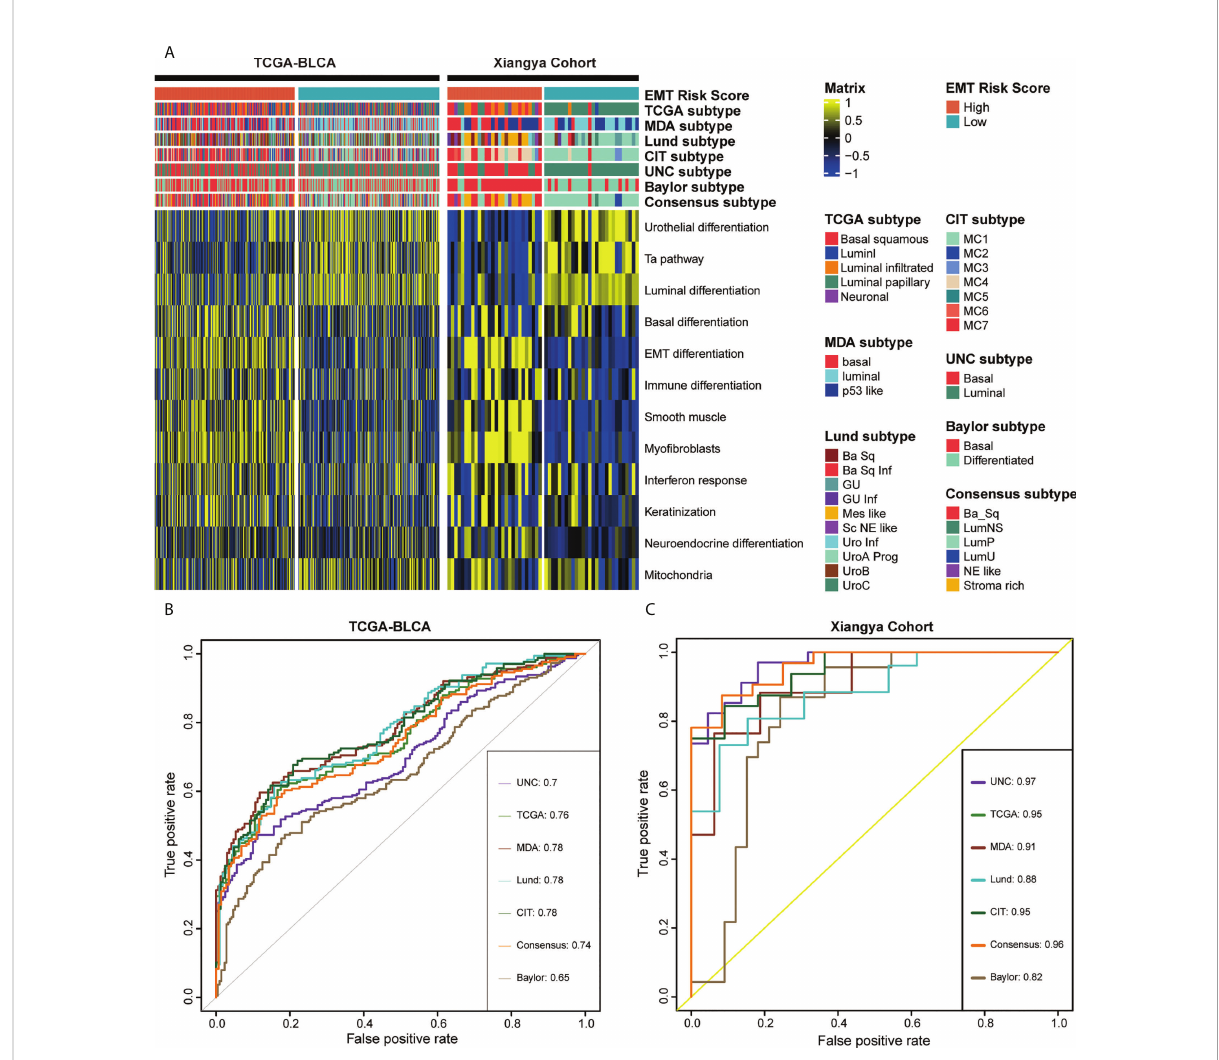
FIGURE 6 EMT risk score predicted molecular subtypes of MIBC in the TCGA-BLCA and Xiangya cohort. (A) The heatmap of different EMT risk score groups, seven molecular subtype classi fi cations and bladder cancer associated signatures in the TCGA-BLCA (left) and Xiangya cohort (right). Activated or inhibited pathways are marked as yellow or blue, separately. (B, C) ROC plot of the EMT risk score for predicting seven molecular subtype classi fi cations in BLCA in the TCGA-BLCA and Xiangya